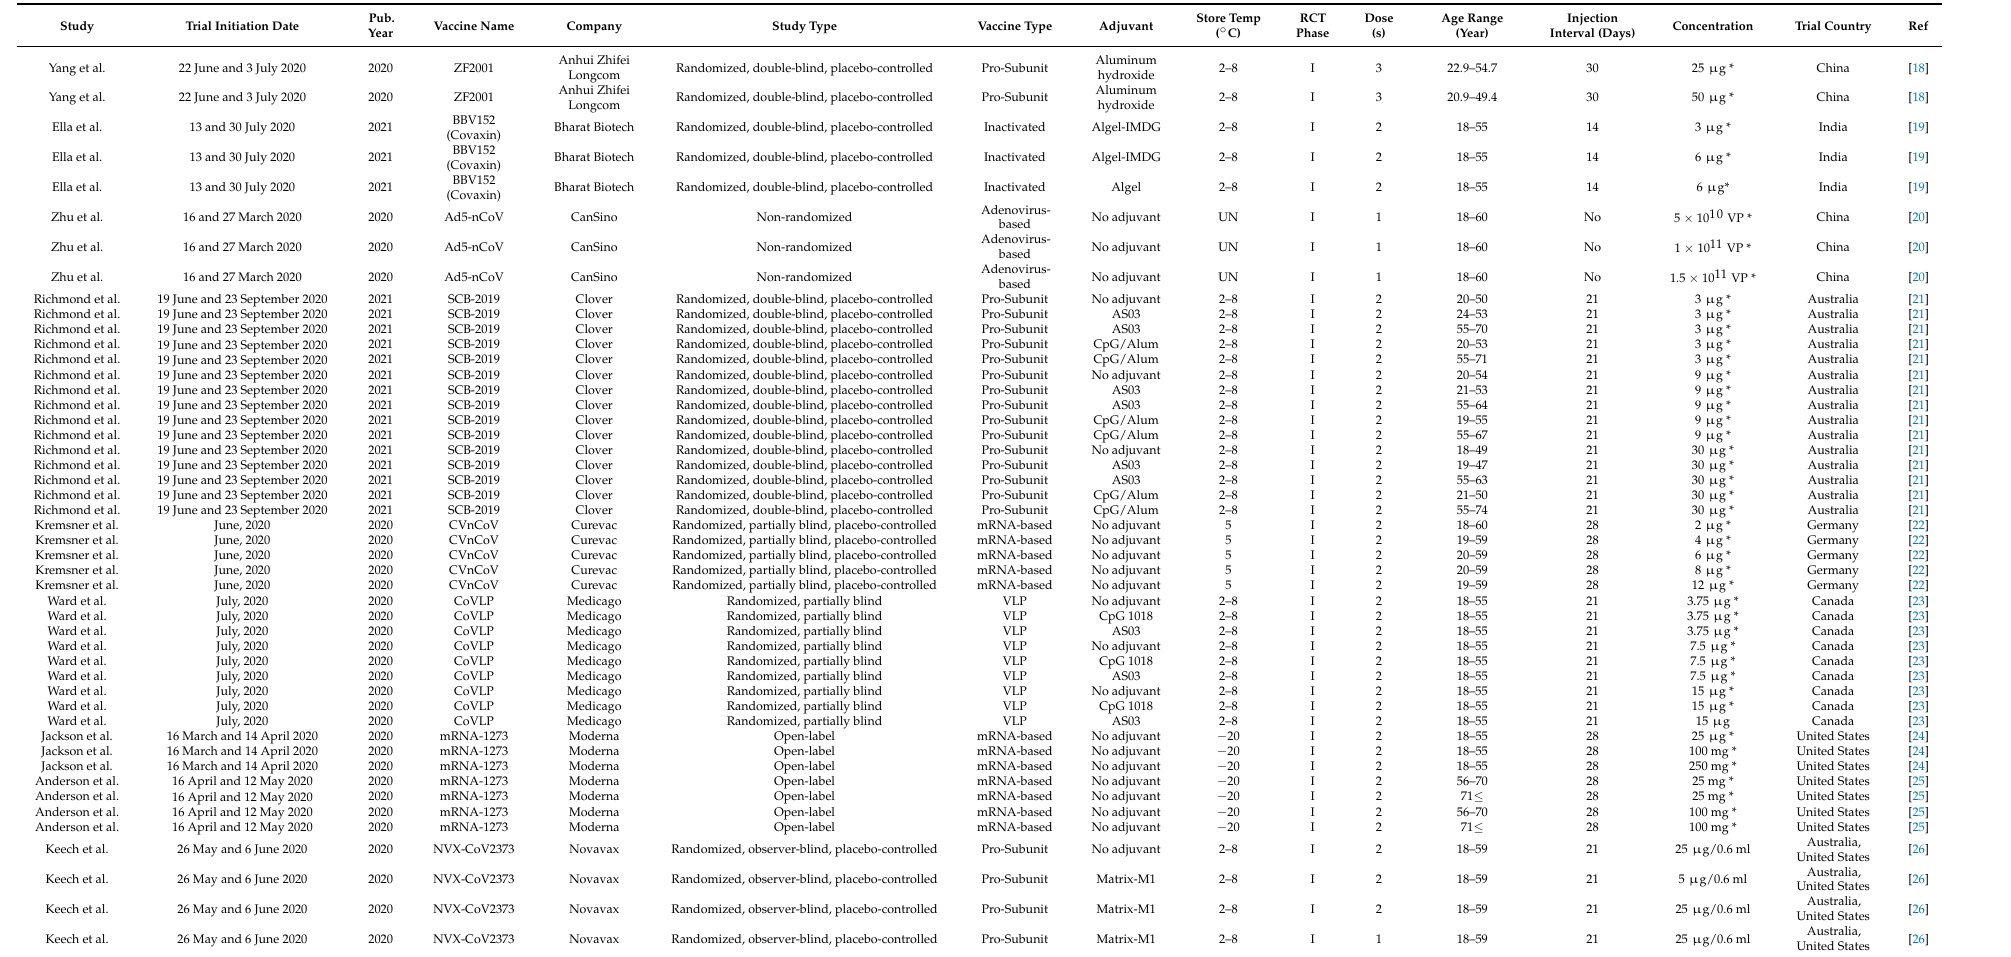
Table 1. Characterization of included